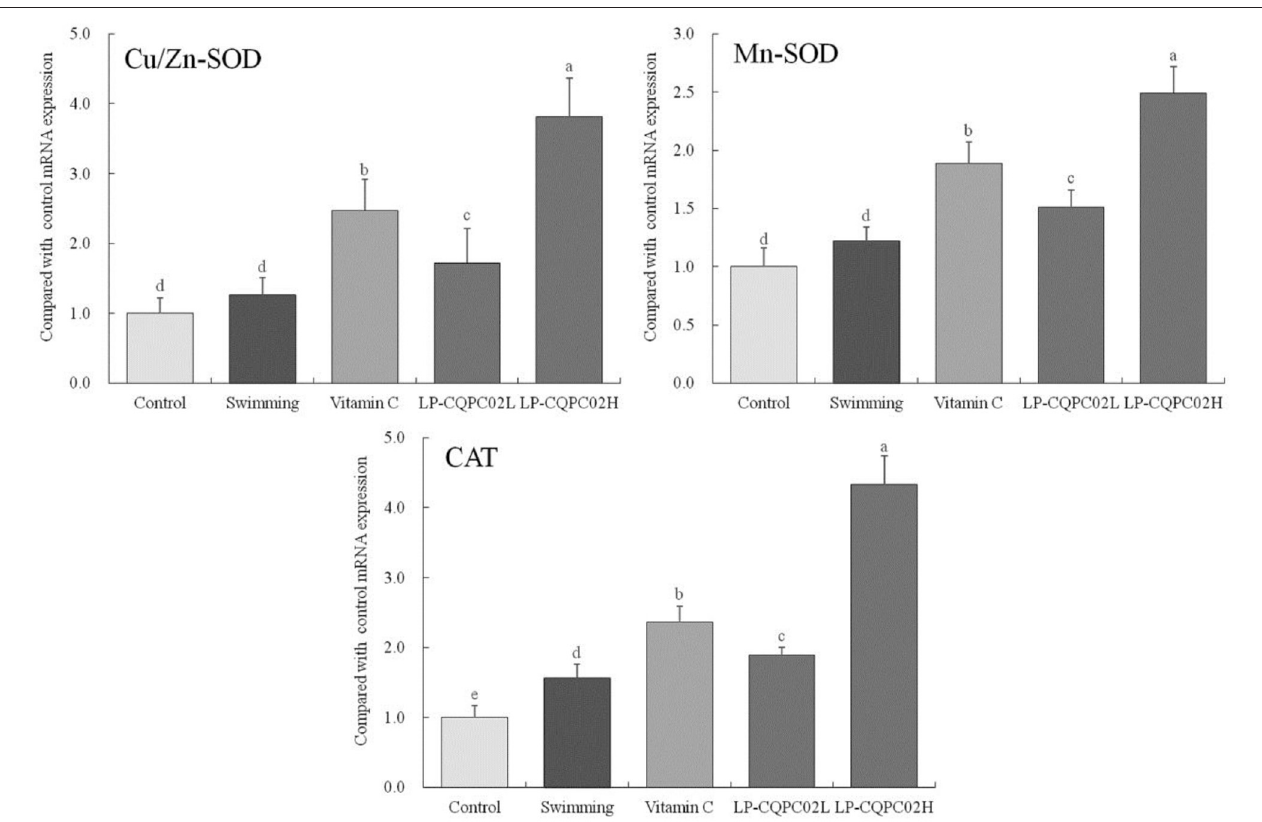
FIGURE 3 | Cu/Zn-SOD, Mn-SOD, and CAT mRNA expression of hepatic tissue in mouse. a − e After the Tukey’s honestly significantly different test analysis, there is significant difference between the two groups with different superscript ( P <